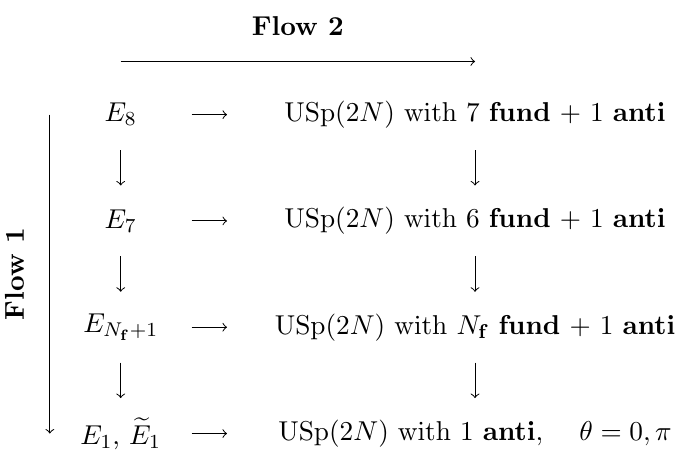
Figure 1. Renormalization group (cid:13)ows across various theories, starting from the Seiberg E 8 theories. On the right, fund and anti denote hypermultiplets transforming in the fundamental and antisymmetric representations of USp(2 N ). Note that for rank-one, there is no antisymmetric representation of